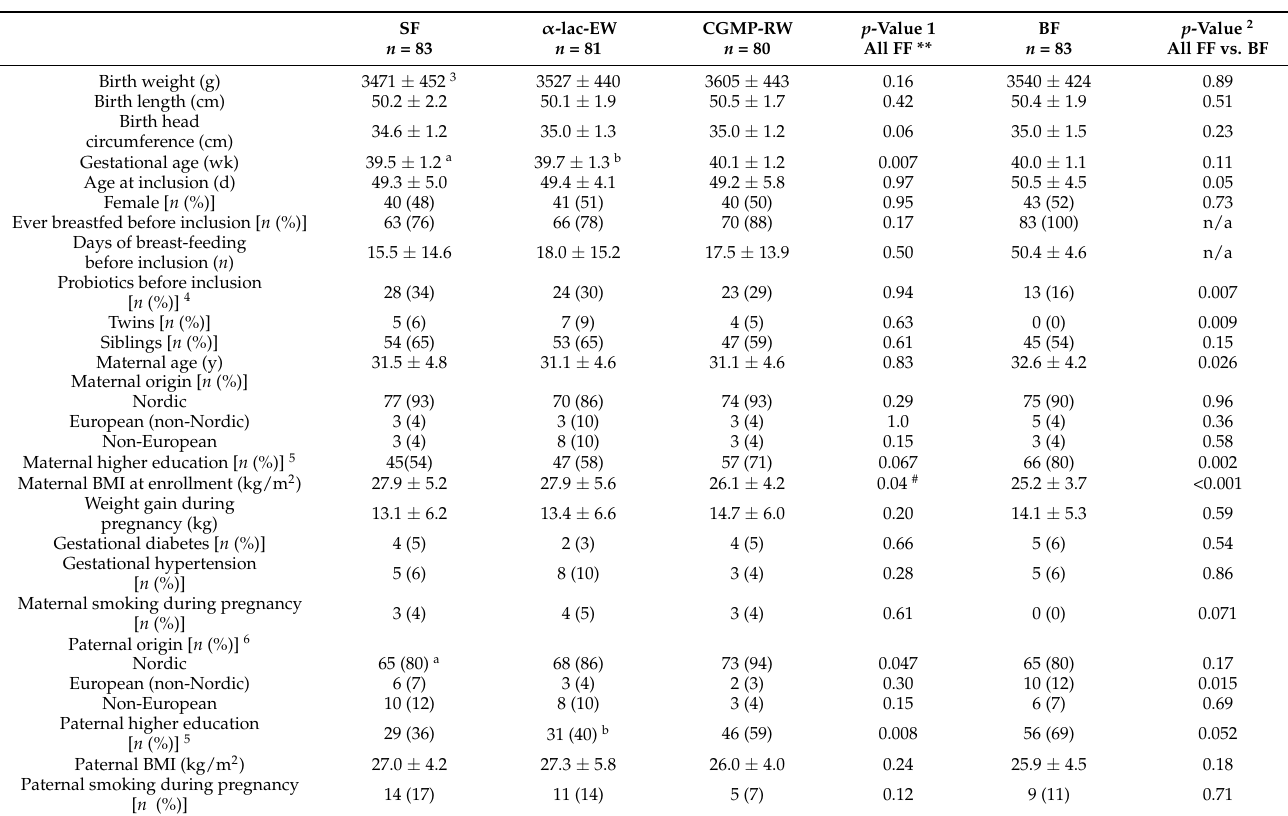
Table 2. Baseline characteristics of parents and infants fed formula (SF, α -lac-EW or CGMP-RW) * or breast milk (BF), ITT population. α -lac-EW SF n = 83 n = 81